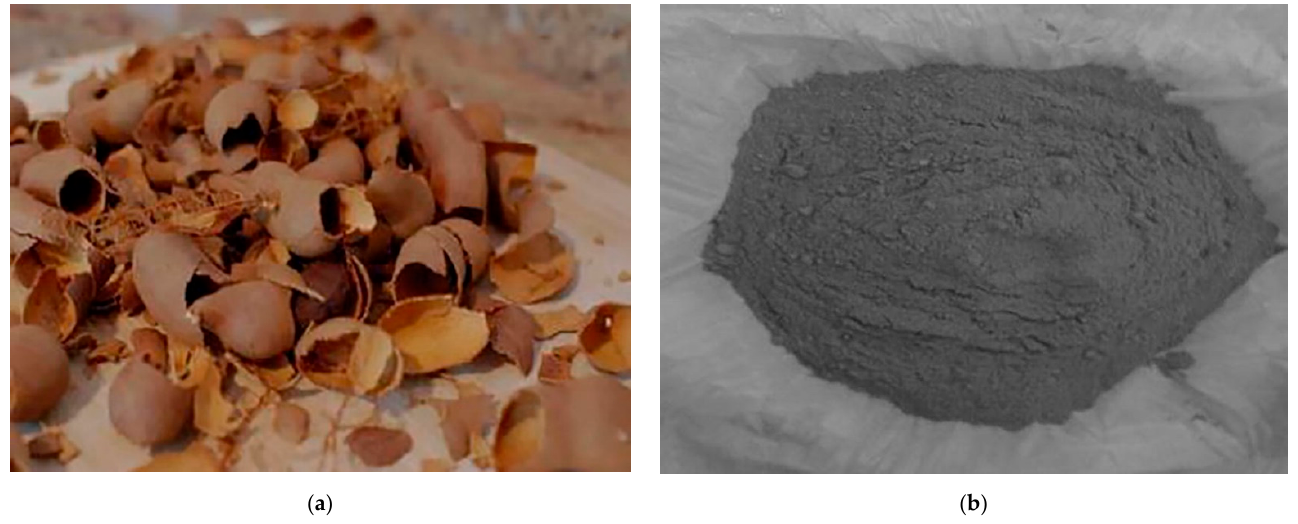
Figure 3. The photograph of ( a ) tamarind shell and ( b ) tamarind shell powder [39] (reproduced with thanks from Elsevier, License Number: 5206490581705).